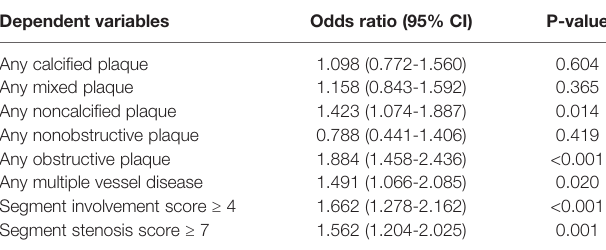
TABLE 3 | Multivariate regression analysis of the association of coronary artery plaques in diabetes with smoking history. Dependent